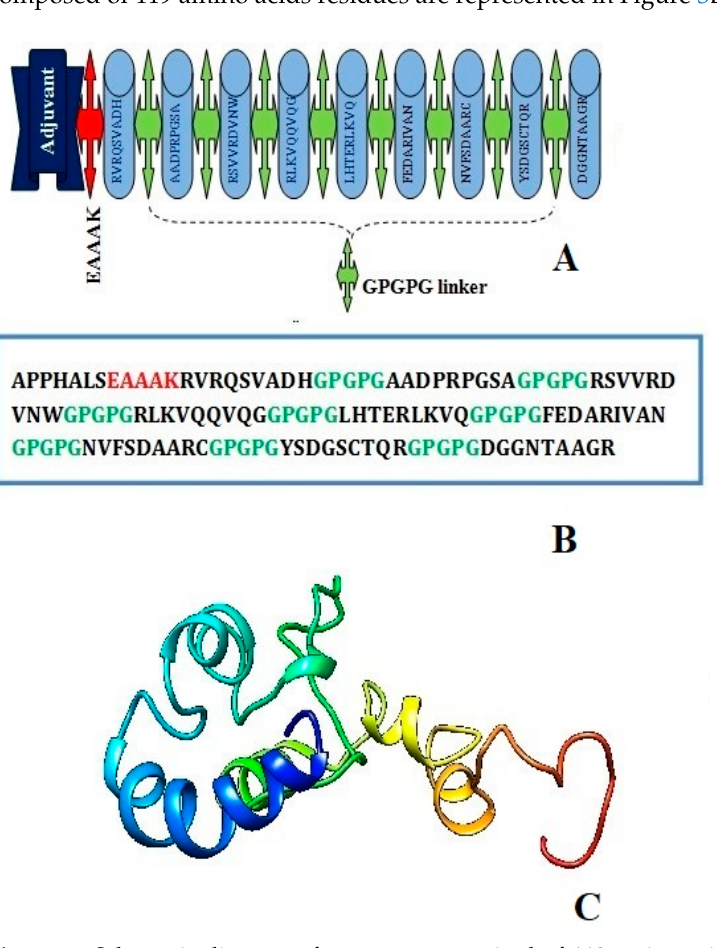
Figure 3. Schematic diagram of construct comprised of 119 amino acid residues; out of which first seven amino acids are TLR4 adjuvant linked with five residues of linker followed by nine immu- nodominant epitopes joined together by GPGPG linker ( A ) chimera sequence ( B ) and 3D structure of original predicted vaccine construct ( C ).